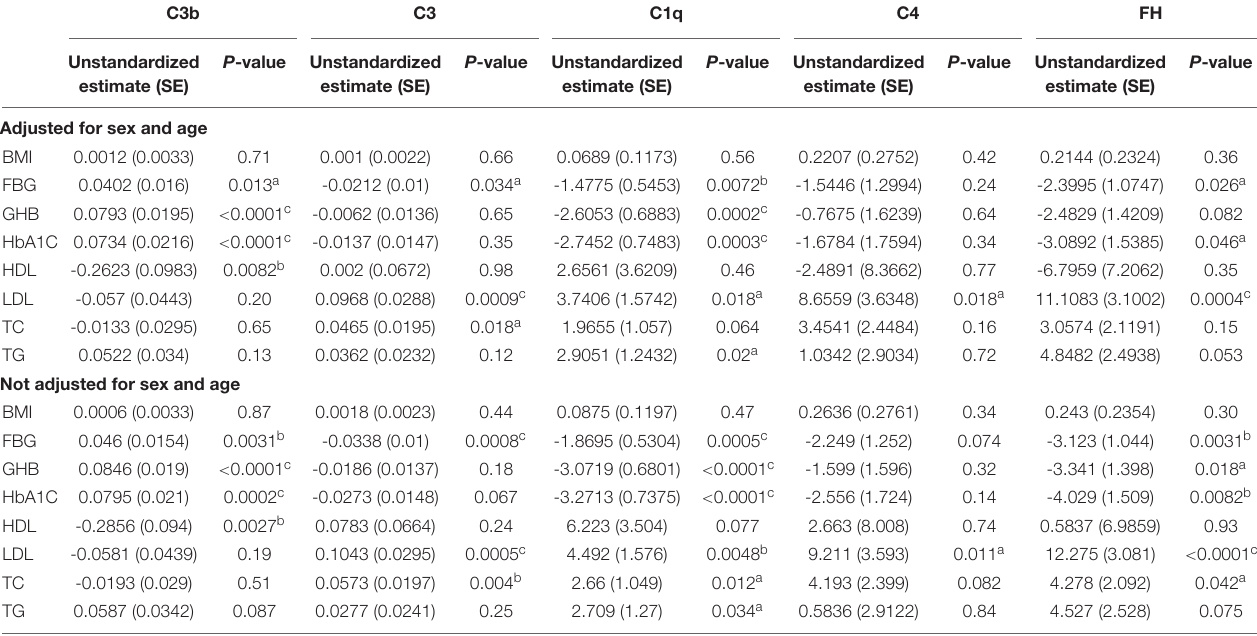
TABLE 2 | Associations of complement protein with clinical